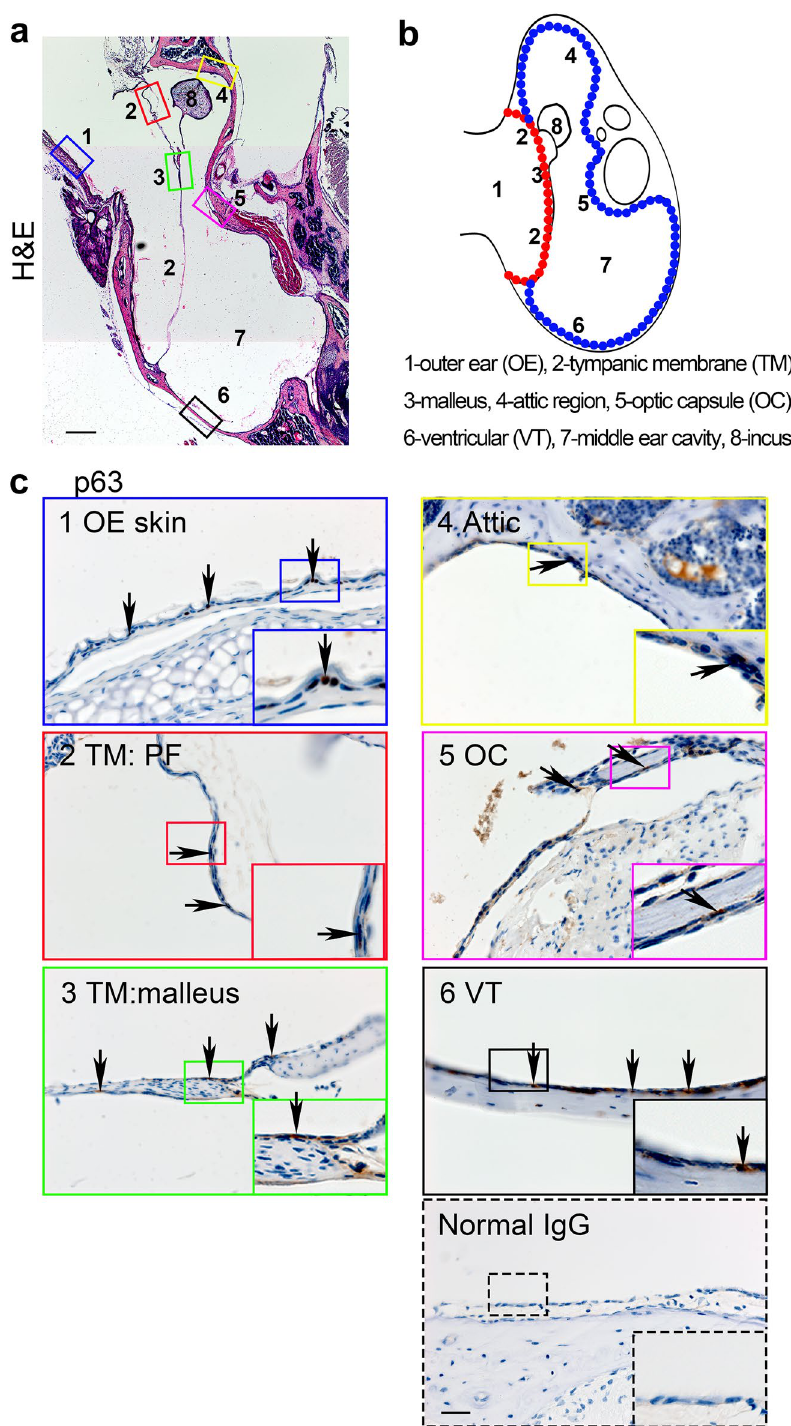
Figure 1. The localization of p63-positive epithelial cells in the mouse temporal bone. ( a ) A representative image of 5 week-old mouse temporal bone stained with hematoxylin and eosin (H&E). The boxes in blue, red, green, yellow, magenta, and black indicate the outer ear (OE), pars flaccida (PF) of the tympanic membrane (TM), malleus, the attic region, the optic capsule (OC), and the ventricular (VT) region, respectively. Scale bar = 1.0 mm. ( b ) A schematic illustration of the temporal bone in mice. The red dots indicate the epithelial layer of the TM, whereas blue dots indicate the epithelial lining of the middle ear cavity. ( c ) Immunostaining of 5 week-old mouse temporal bone stained with anti-p63 monoclonal antibodies. The arrows indicate representative p63-positive epithelial cells. Insets on the bottom right corner in each panel show higher magnification of the corresponding boxed area. The lower right panel shows an example of middle ear epithelium stained with normal rabbit IgG, serving as a negative control. Scale bar = 50